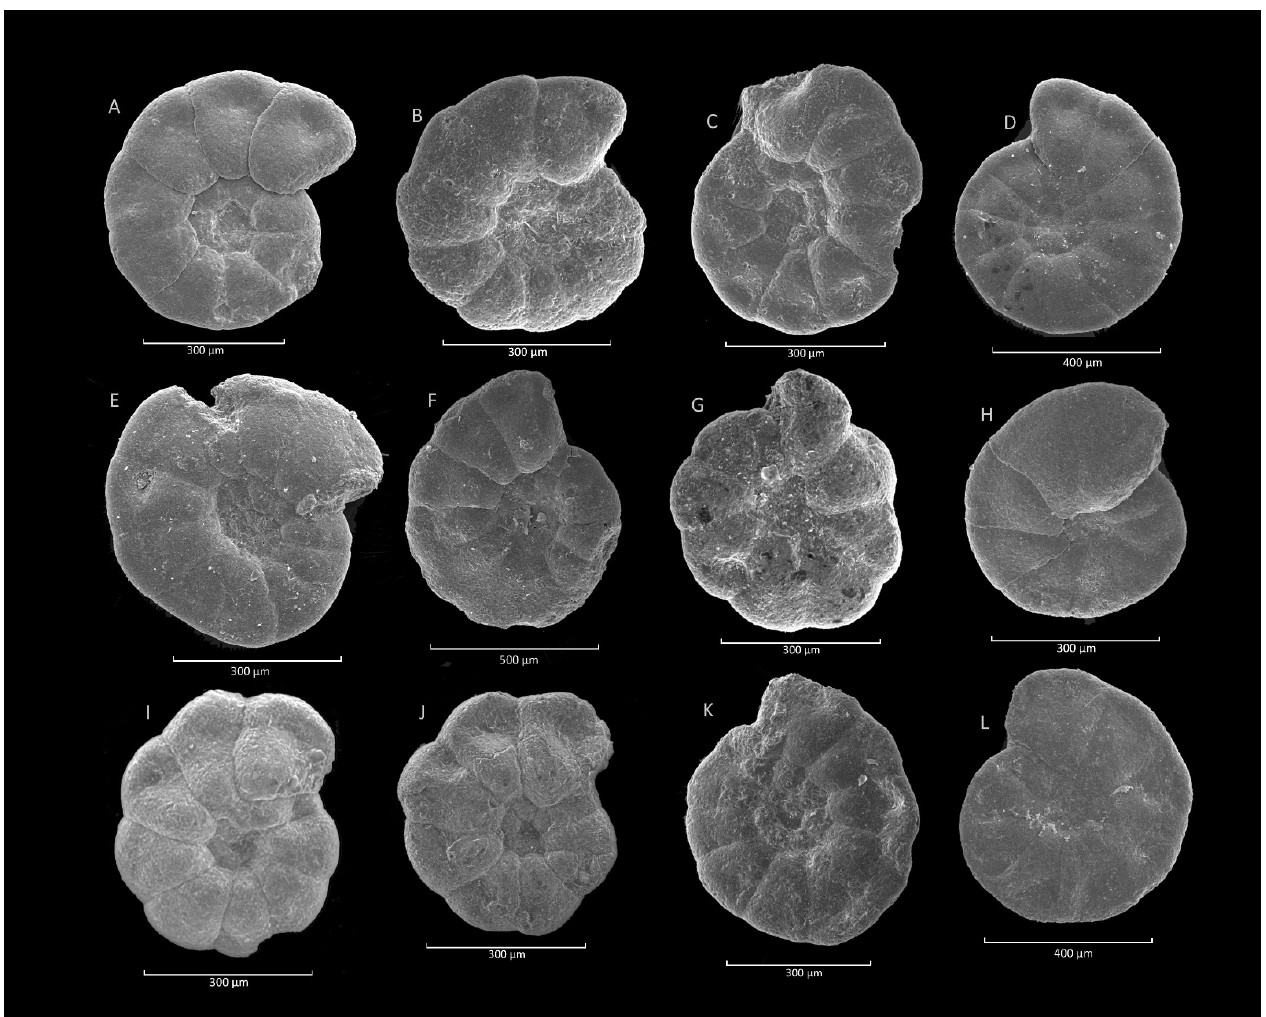
Figure 19. Haplophragmoides nauticus Kender, Kaminski et Jones. ( A – F ): Krzes ł awice section; ( G ): Leszczawa section; ( H ): Sk ł ady section; ( I , J, K ): Lipie section; ( L ): Sk ł ady section;